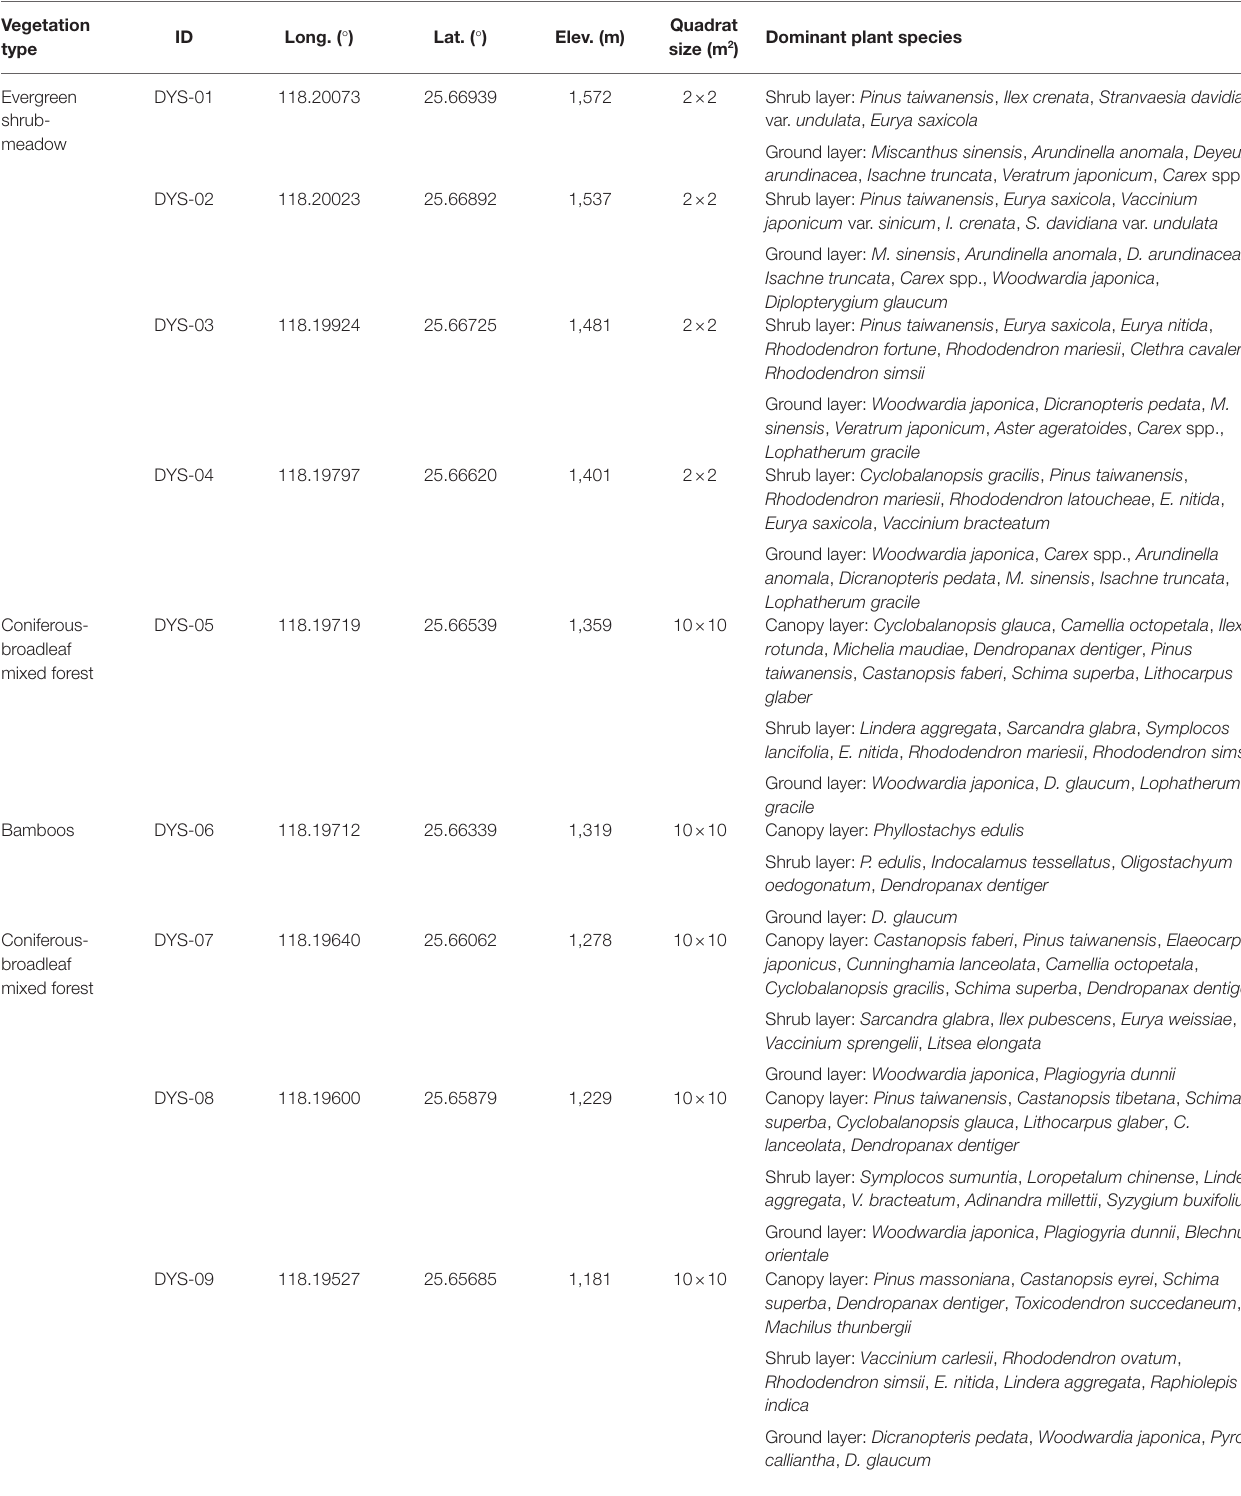
TABLE 1 | Location, elevation, and dominant plant species for topsoil samples collected in the Daiyun Mountains. Vegetation